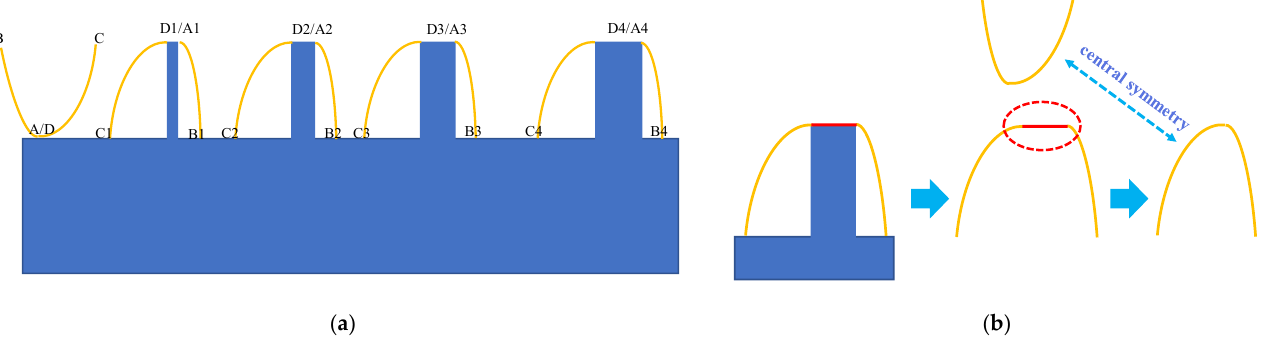
Figure 3. The principle of tip characterizer to reconstruct the AFM tip structure: ( a ) Imaging process; ( b ) Reconstruction process.